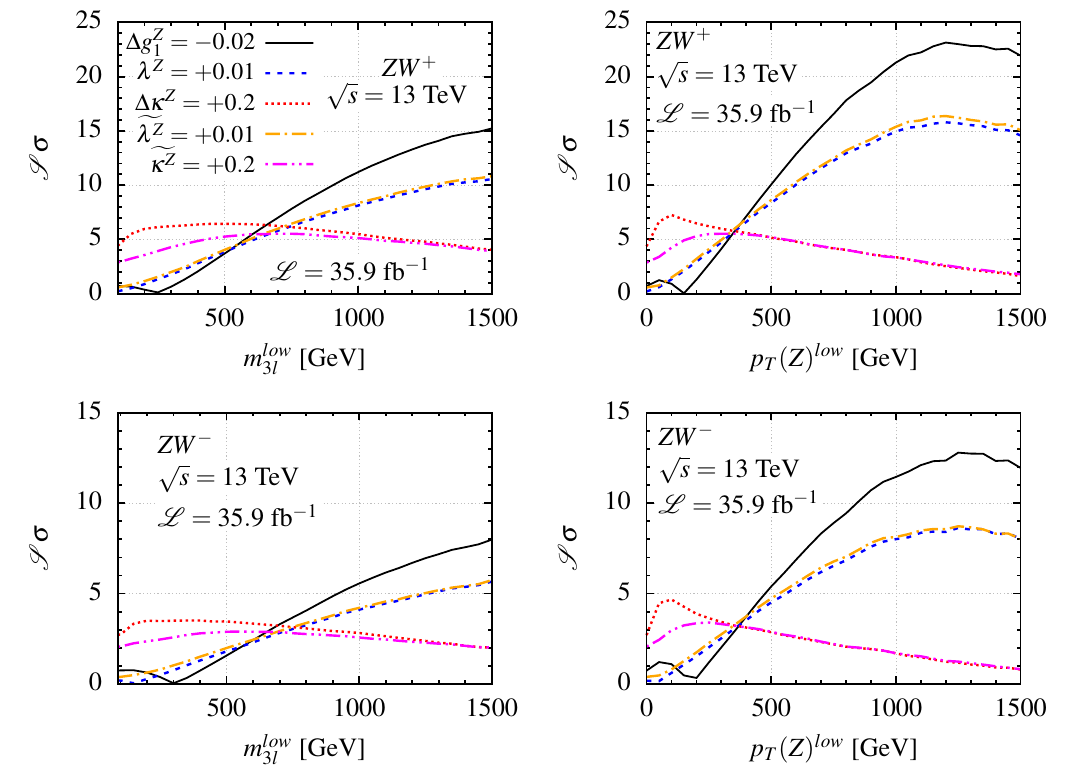
Figure 4 . The sensitivities of cross sections to the (cid:12)ve benchmark aTGC as a function of the lower cut on m 3 l and p T ( Z ) in the ZW (cid:6) production at the LHC at p s = 13 TeV and L = 35 : 9 fb (cid:0) 1